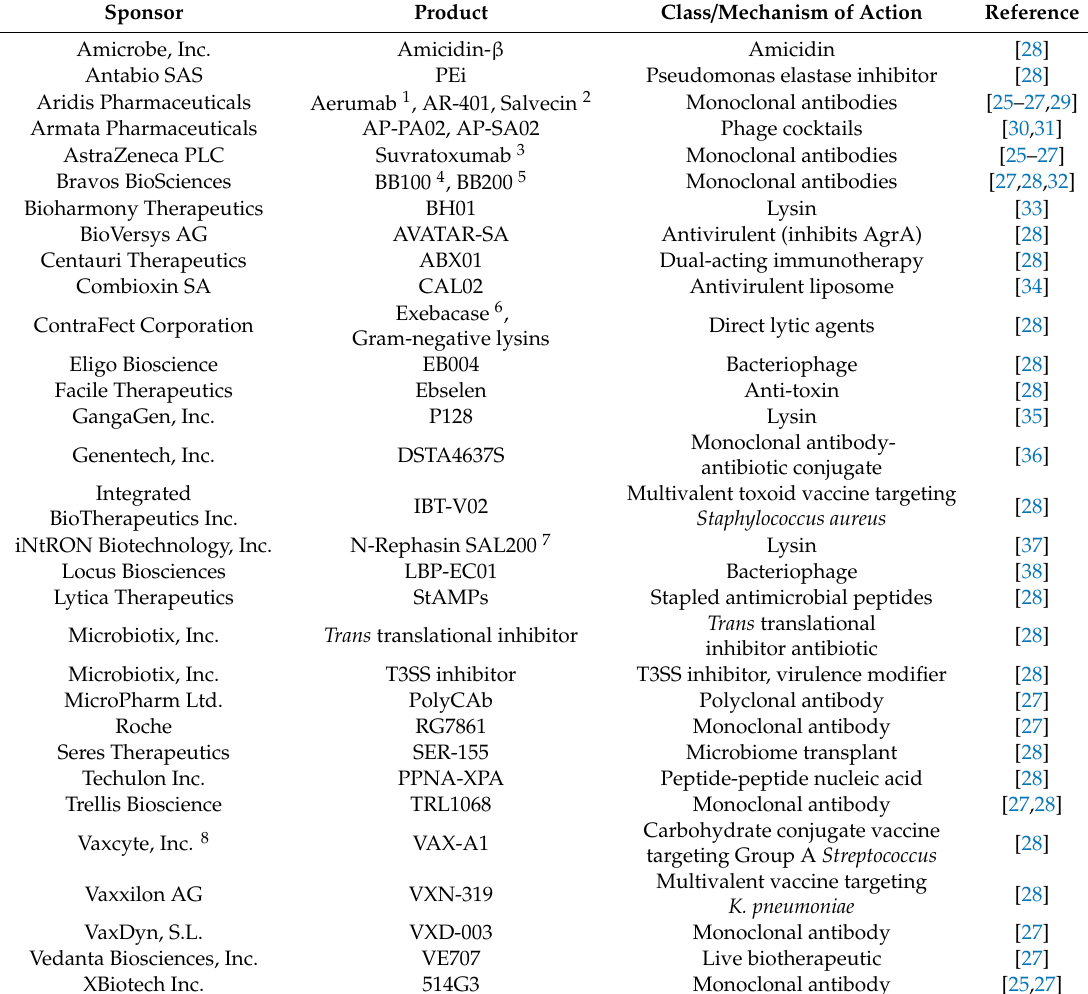
Table 2. Novel investigational therapeutic approaches to treat patients infected with antibiotic- resistant